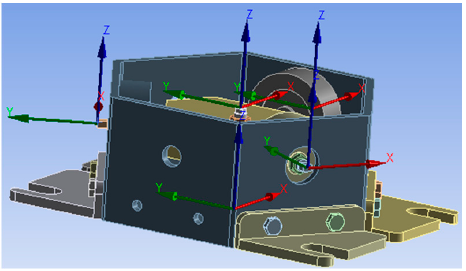
Figure 16. Coordinate system of the sensor.